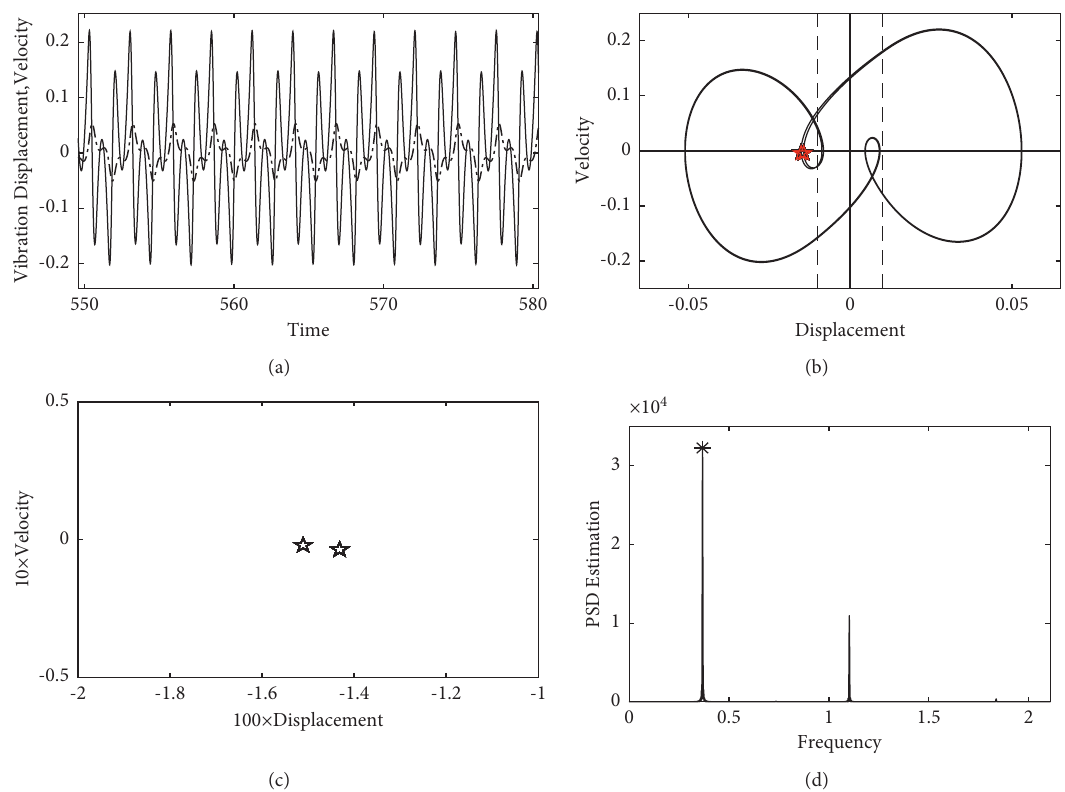
Figure 12: f � 0 . 3674Hz, asymmetric period 2-4-2. (a) Time history graph. (b) Phase diagram. (c) Poincar´e section. (d) Power spectral density